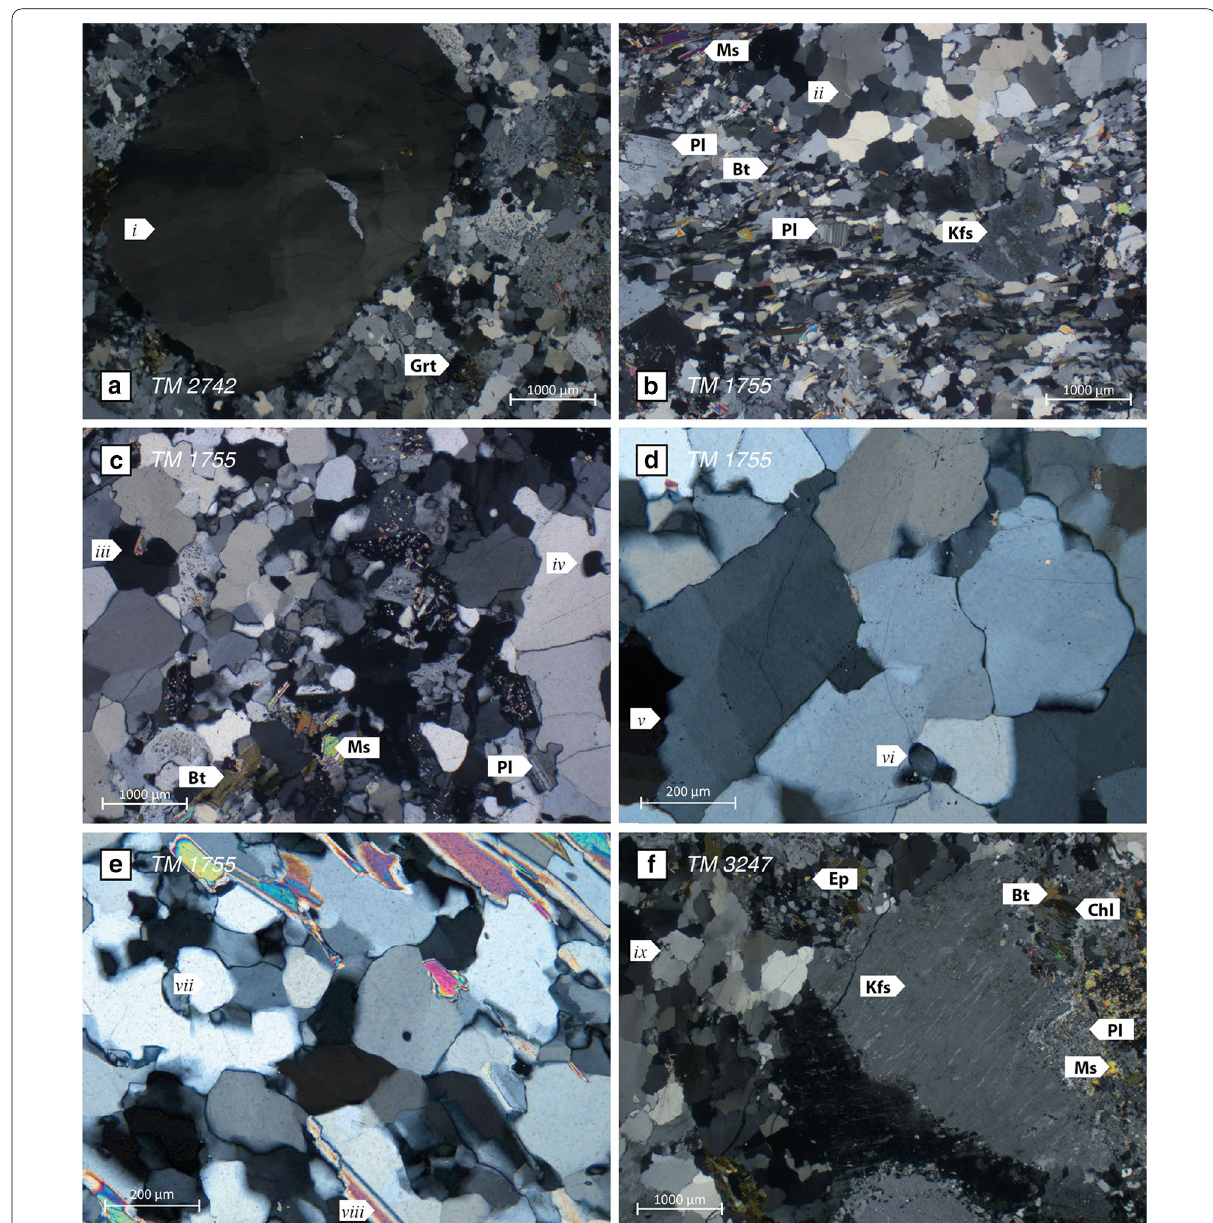
Fig. 7 Thin section cutouts of RG1 ( a – e ) and RG2 ( f ), crossed polarized light in all photomicrographs. Mineral abbreviations according to Whitney and Evans (2010) (this is also valid for subsequent figures with photomicrographs and will no longer be mentioned). The italic roman numbers correspond to descriptions related to dynamic recrystallization (Sect. 3.2.4): ( i ) magmatic quartz with grain size > 4 mm showing undulose extinction, ( ii ) dynamically recrystallized quartz in coarse-grained domain, ( iii ) pinning structure in coarse-grained domain, ( iv ) ‘left-over’ grain in coarse-grained domain, ( v ) irregular grain-boundary in coarse-grained domain, ( vi ) ‘left-over’ grain in coarse-grained domain, ( vii ) slightly elongated grain in fine-grained domain, ( viii ) potential pinning of quartz by the indicated white mica grain, ( ix ) coarse-grained domain in a RG2